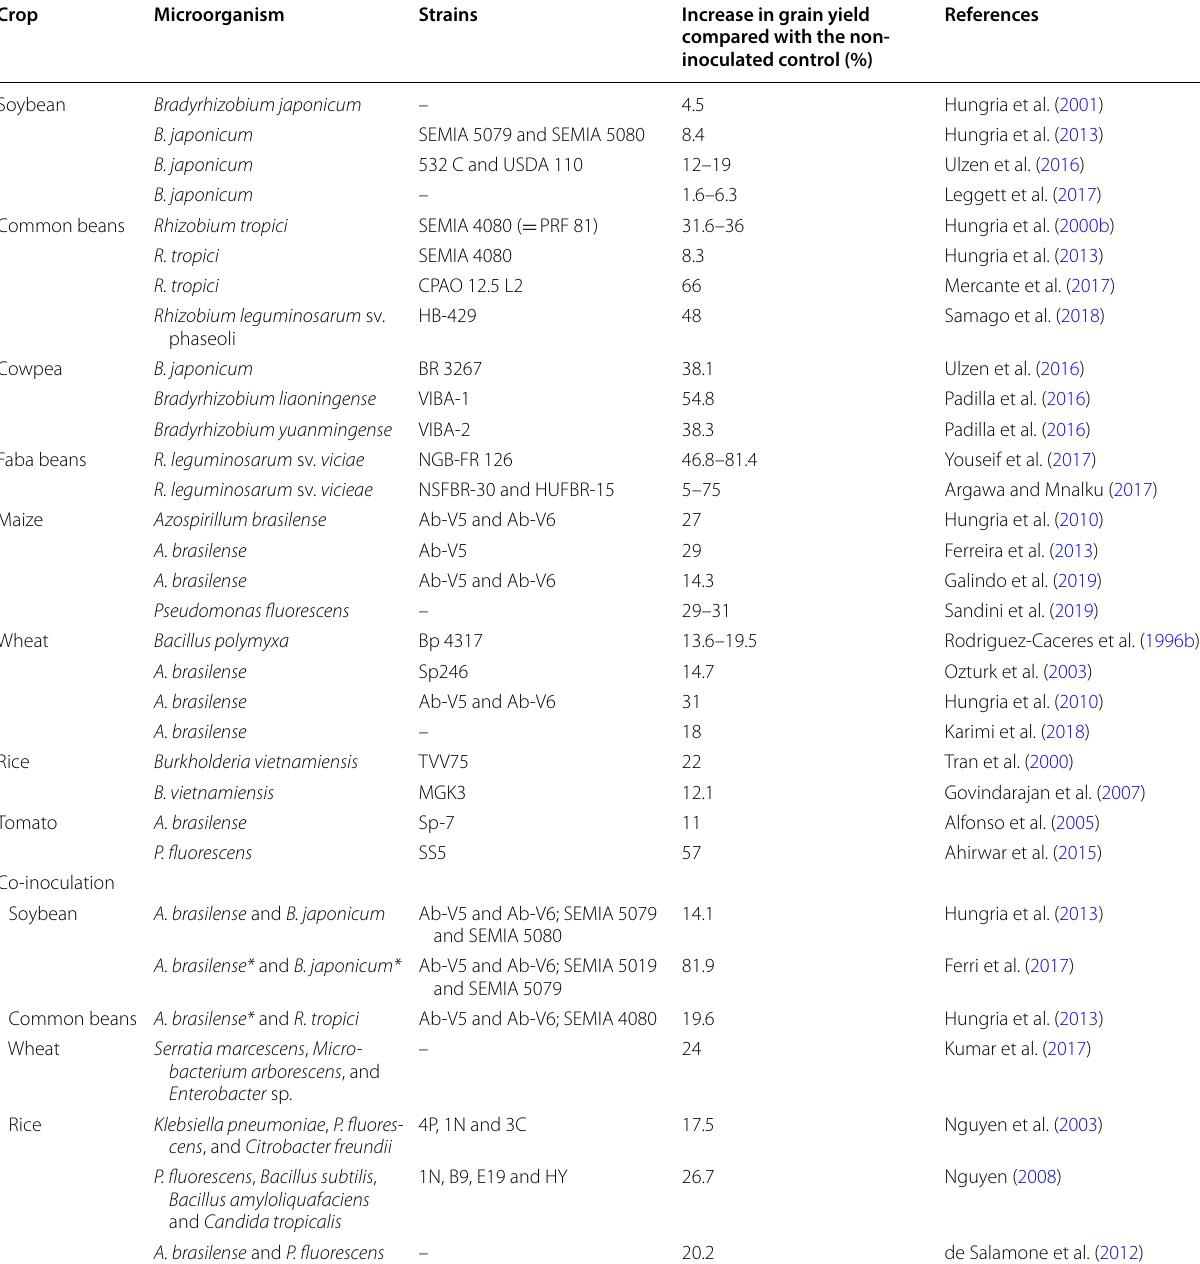
Table 1 Examples of studies comprising inoculation of various plant species with specific bacterial strains resulting in increased grain